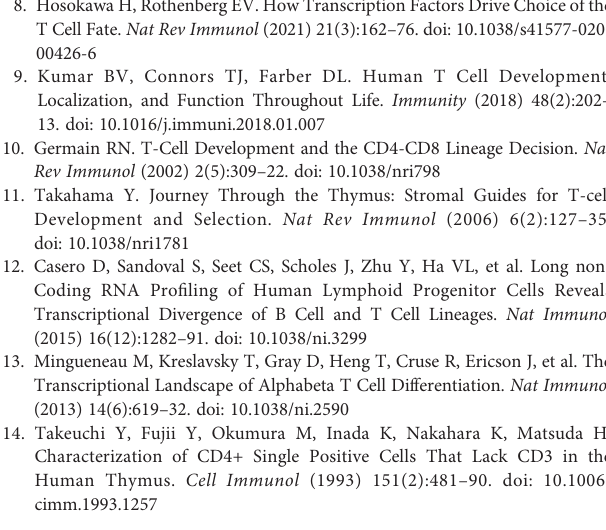
Figure 2B . Supplementary Table 3 | (related to Figure 5, 6 , Supplementary Figure 4 , 5 ): Results from correlation analyses between extracellular fl ux and transcriptional data in mouse and human thymocytes. Supplementary Table 4 | Key Resource